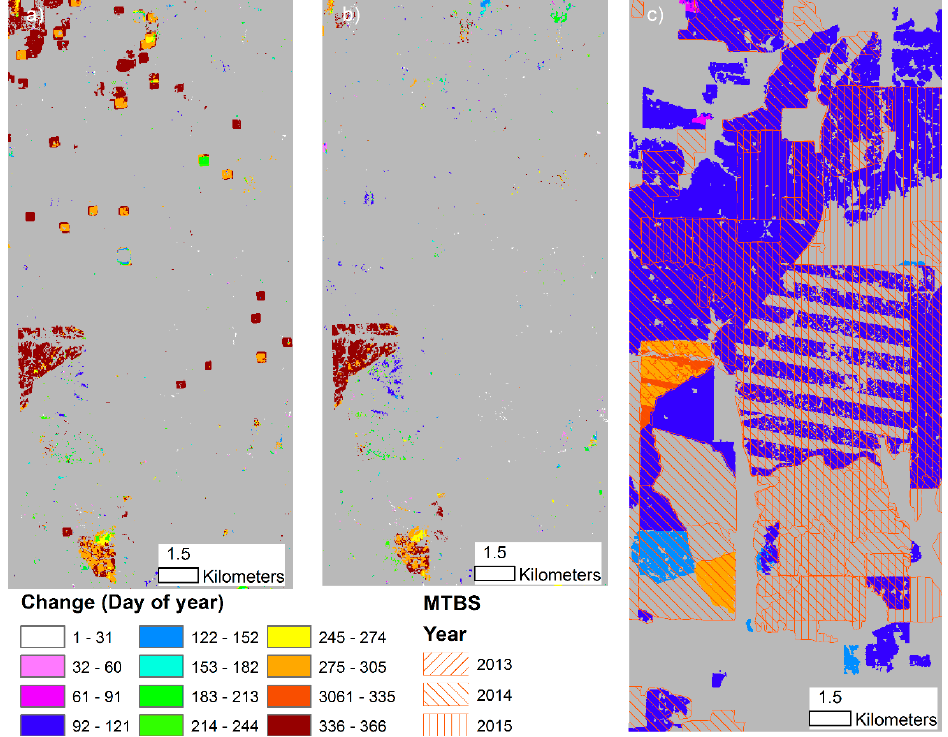
Figure 8. Detection of burned areas from ( a ) Landsat-8 data only and ( b ) HLS data compared with ( c ) reference products BAECV 2016 (background map) and historical MTBS.